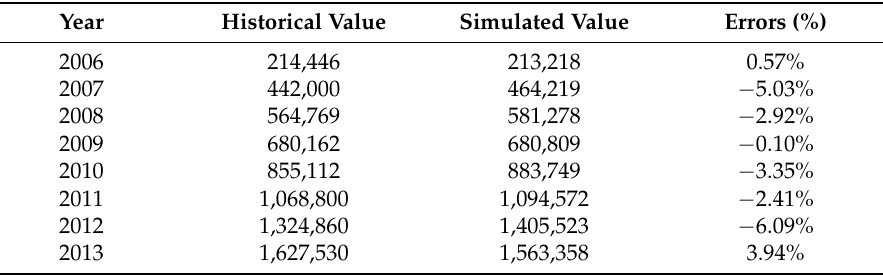
Table 2. Simulated errors of total investment (10 thousand